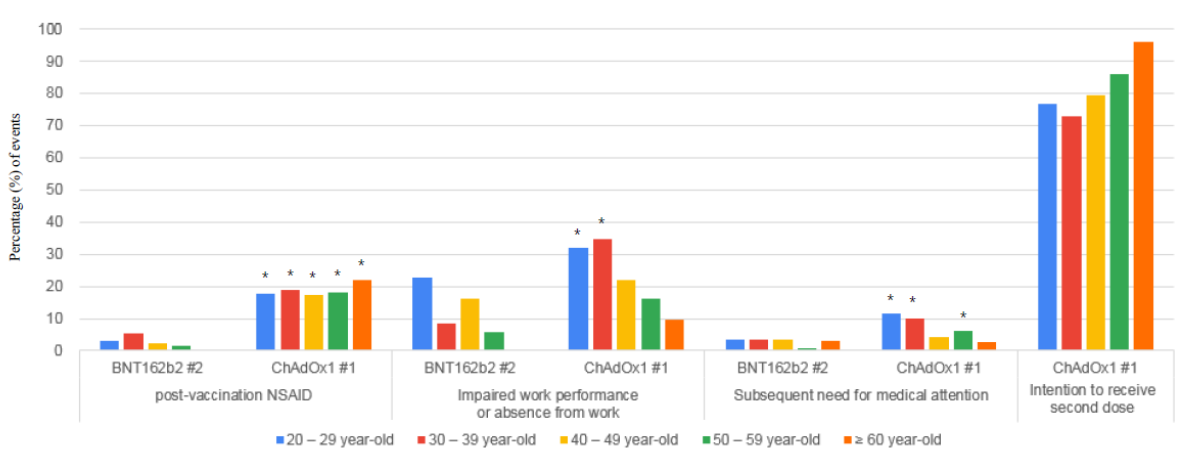
Figure 3. Side effects and their impactson post-vaccination medication, work, and medical use after the first dose of ChAdOx1and the second dose of BNT162b2 vaccination according toage groups. ChAdOx1 #1, the first dose of ChAdOx1; BNT162b2 #2, the second dose of BNT162b2; NSAID, nonsteroid anti-inflammtory drug. * p -value < 0.05 when comparing frequencies of events between BNT162b2 #2 and ChAdOx1 #1 groups for those belonging to the same age group.